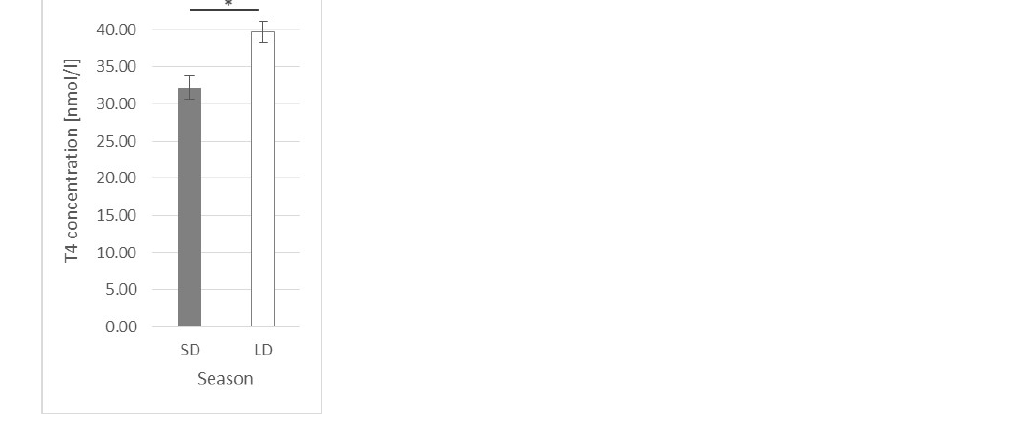
Figure 10. Plasma thyroxine (T4) concentration—comparison between short-day (SD) and long-day (LD) seasons at a 0 h time point; *—indicates p ≤ 0.05, according to Student’s t -test ( n = 24).